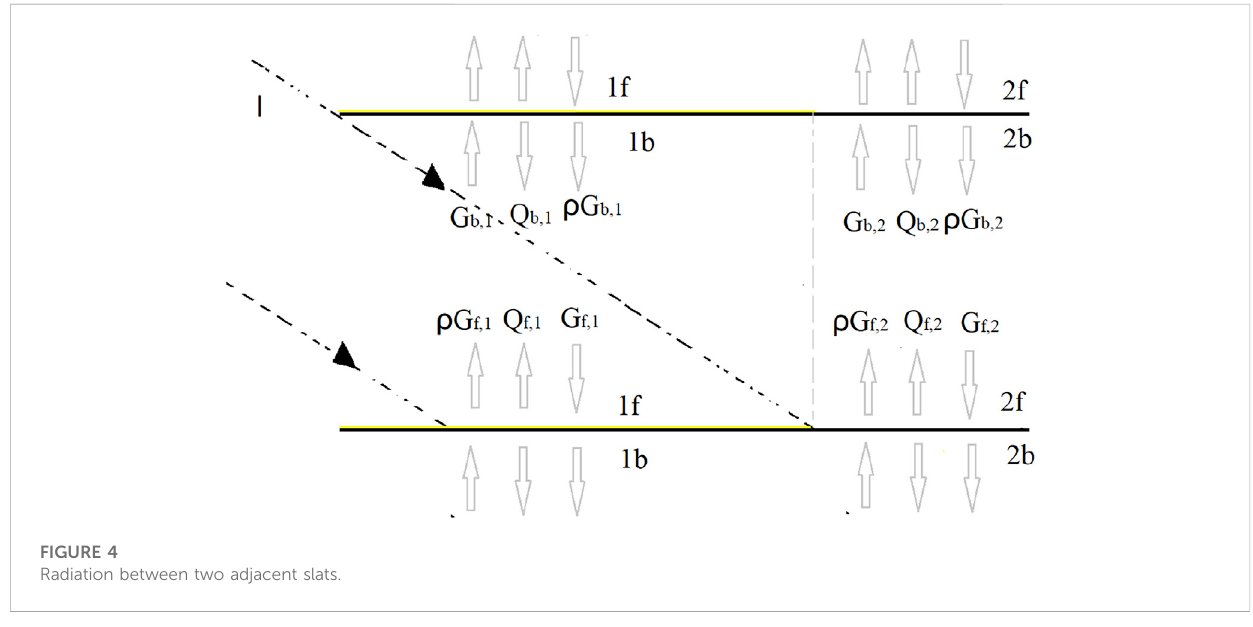
FIGURE 4 Radiation between two adjacent slats.